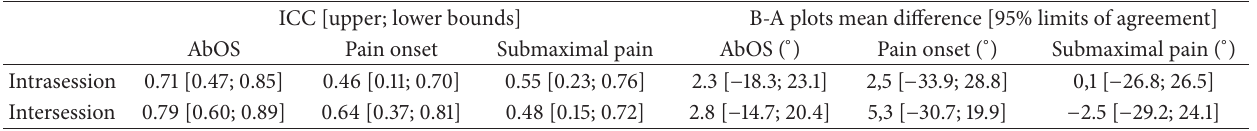
Table 2: Intraclass correlation coefficients (ICC) and Bland-Altman plots (B-A plots) values for the angle between PO and SP (AbOS) and the angle of occurrence in range of PO and SP.